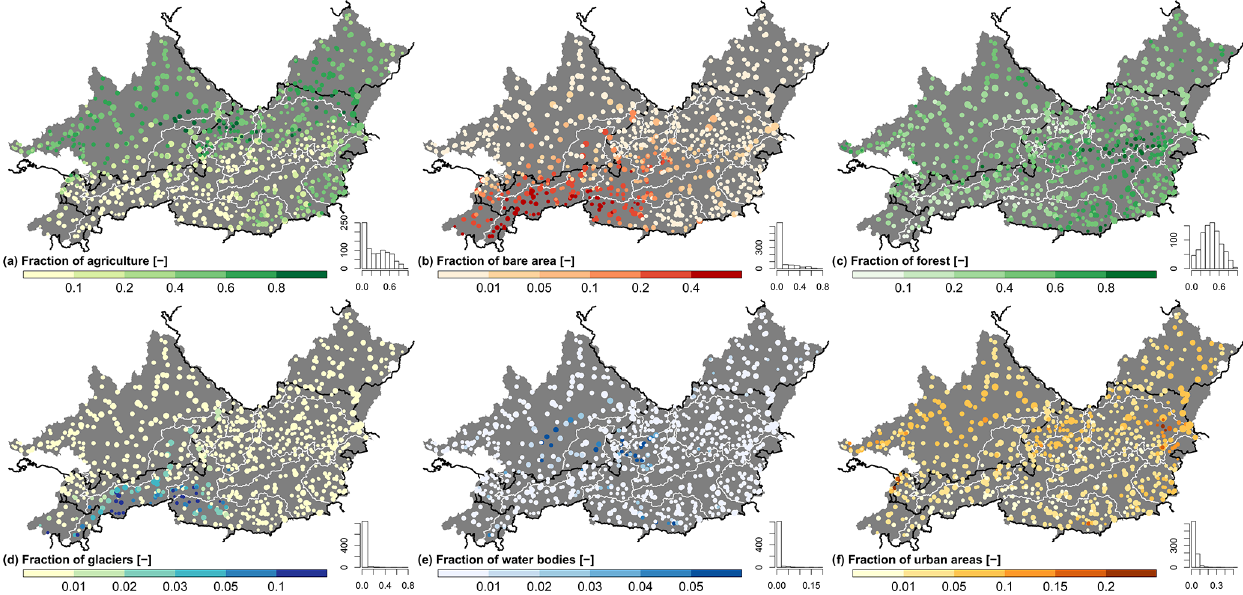
Figure 8. Spatial distribution of land class fractions representing the characteristics of the entire topographic catchment (basin delineation A, Fig. 2a). The histograms indicate the number of basins (out of 859) in each category. The size of the circles is proportional to the catchment area. © EuroGeographics for the administrative